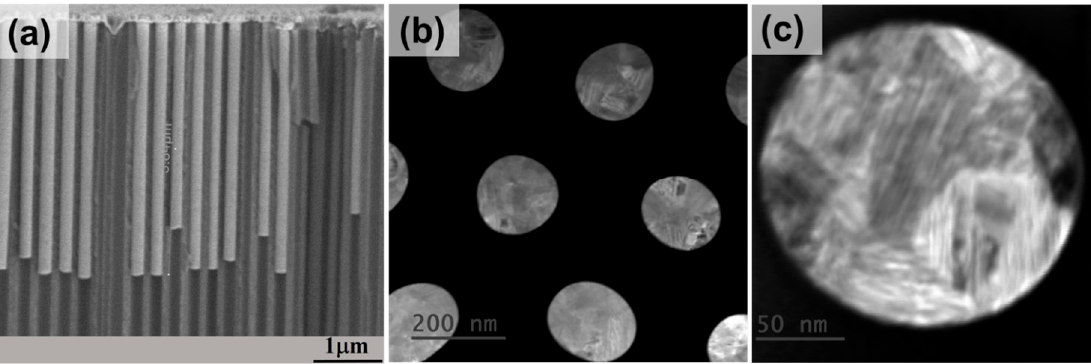
Figure 1. ( a ) Cross-section SEM image of AAO membrane filled with Co nanowires; ( b ) Top STEM image of the Co nanowires within the membrane; ( c ) closer look of a single nanowire presenting crystallites with different orientations.